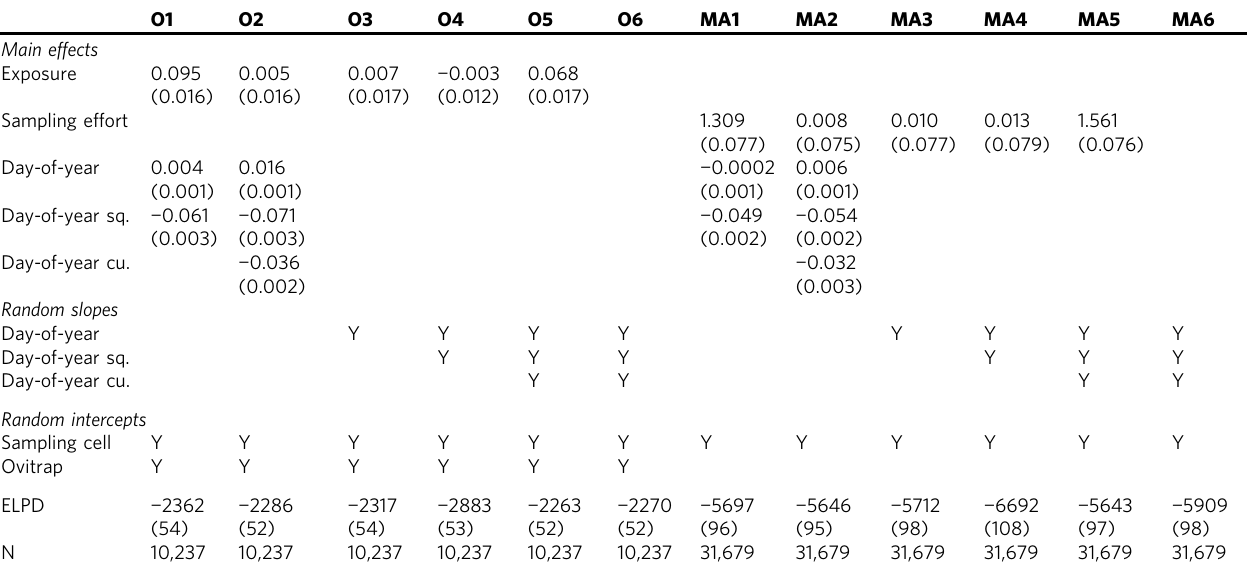
Table 2 Ovitrap (O1 – O6) and Mosquito Alert (MA1 – MA6) model